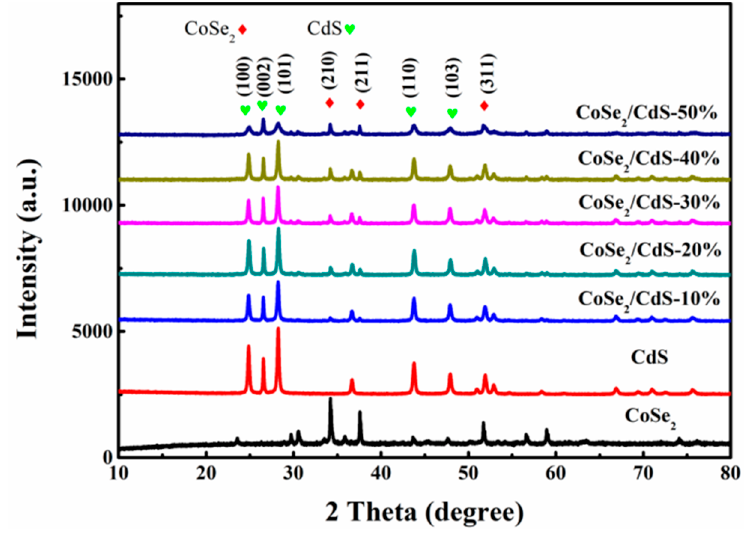
Figure 2. XRD pattern of pure CdS, CoSe 2 and CoSe 2 / CdS ranging from 10% to 50%.